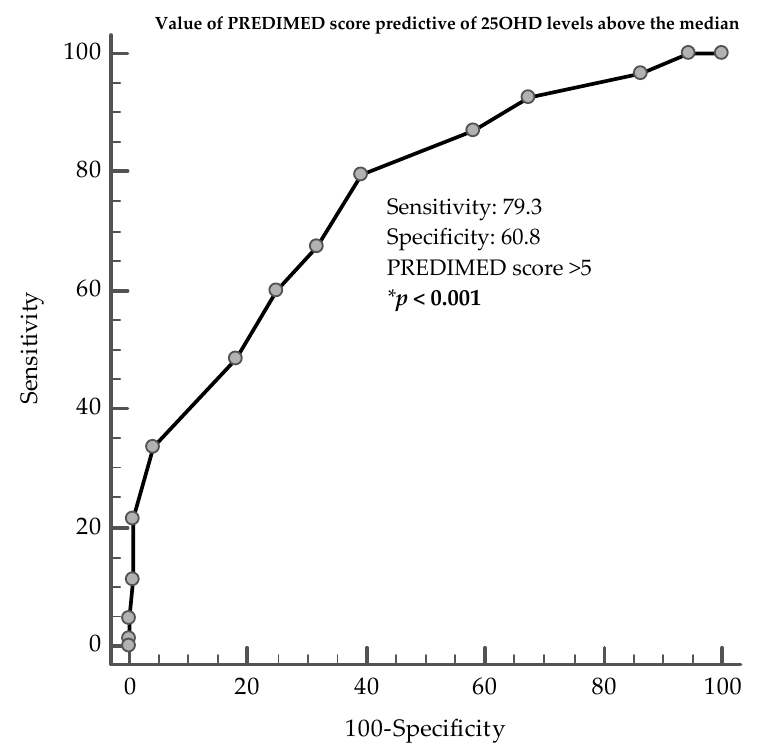
Figure 4. ROC for value of PREDIMED score predictive of 25OHD levels above the median, in females. * A p -value in bold type denotes a significant difference ( p < 0.05).